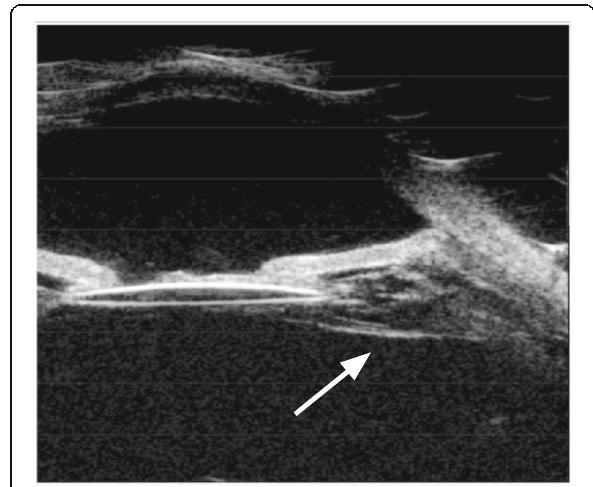
Fig. 2 Anterior extension of cyclitic membrane towards intraocular lens. 800 × 689 mm (72 × 72